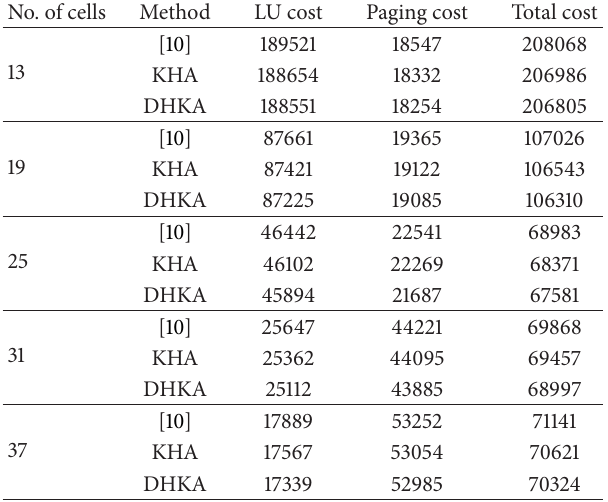
Table 2: Results obtained for LA minimization problem using various